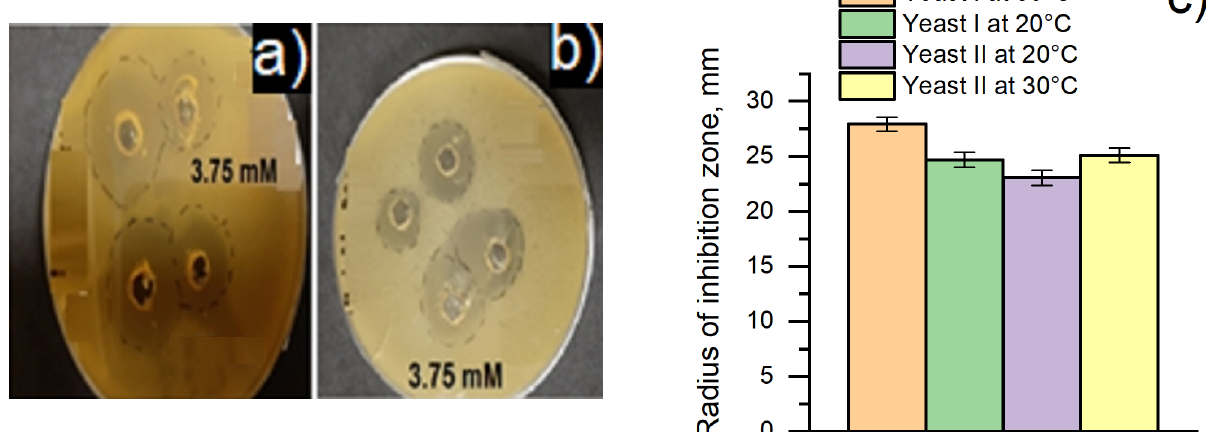
Figure 2. Antimicrobial activity of MD solution evaluated by the agar well diffusion method against yeast cells: ( a )—yeast I ((i) Saccharomyces cerevisiae ) at 30 °C); ( b )—yeast II ((ii) baker’s yeast) at 30 °C; ( c )—the histogram presents the radius of the inhibition zone at 3.75 mM concentration of MD in the solution.